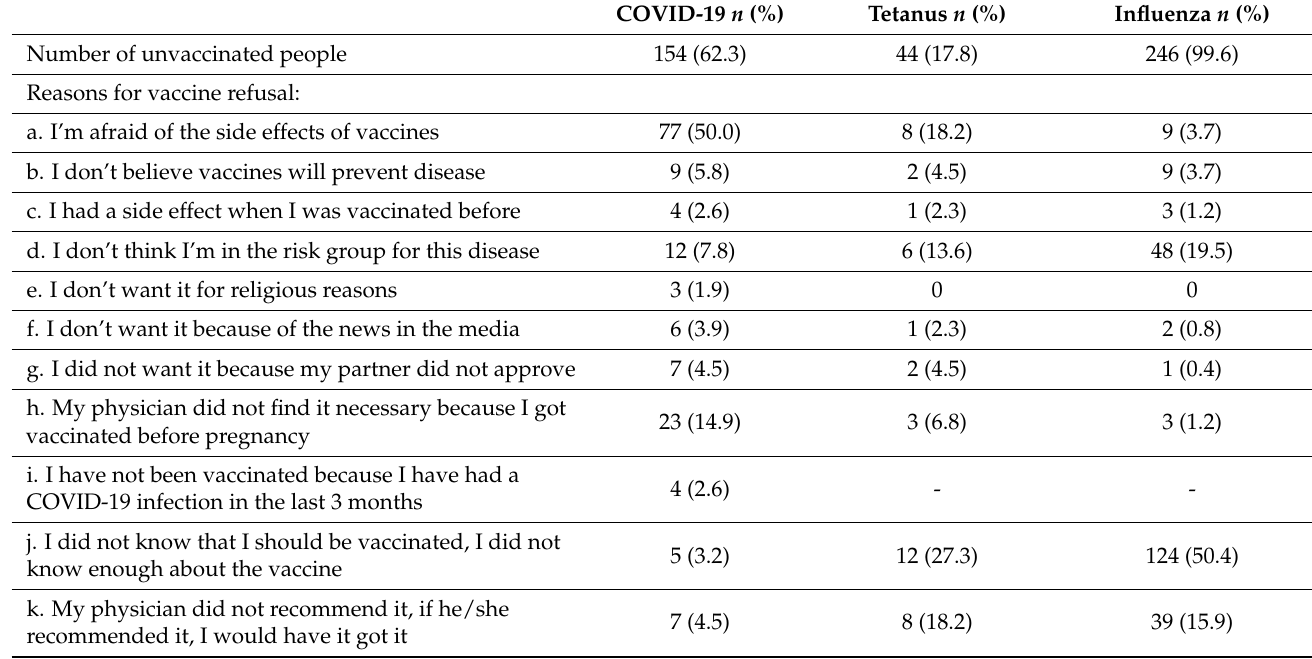
Table 3. Identification of specific causes of vaccination refusal in unvaccinated pregnant